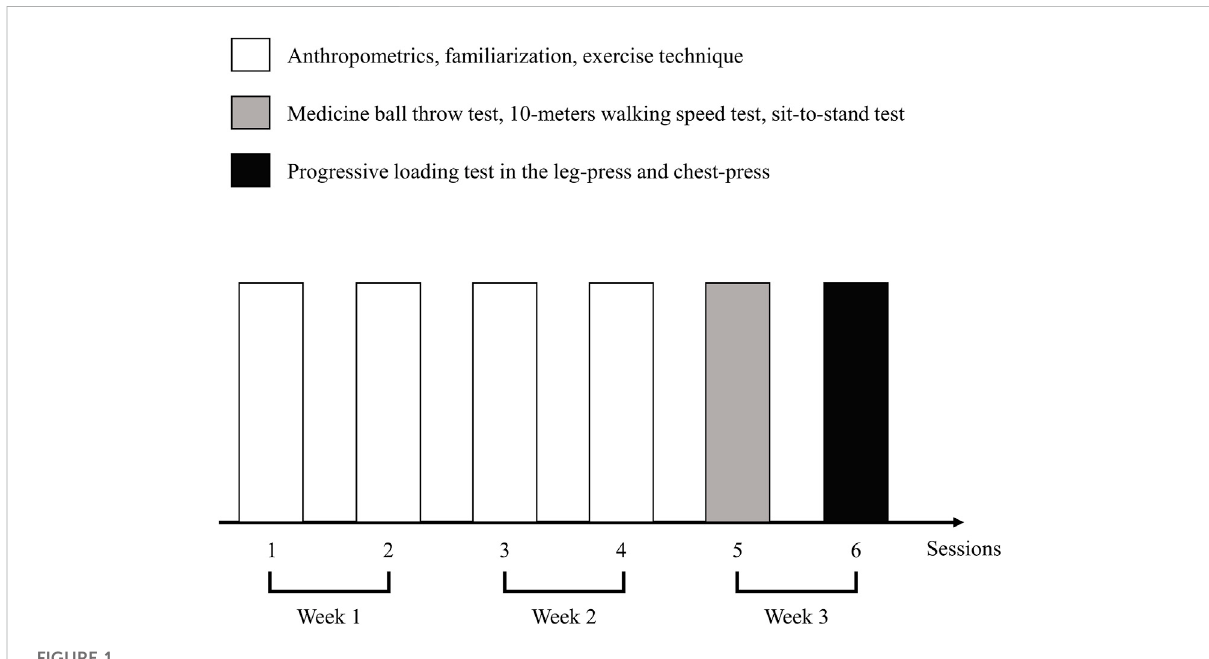
FIGURE 1 Illustration of the study